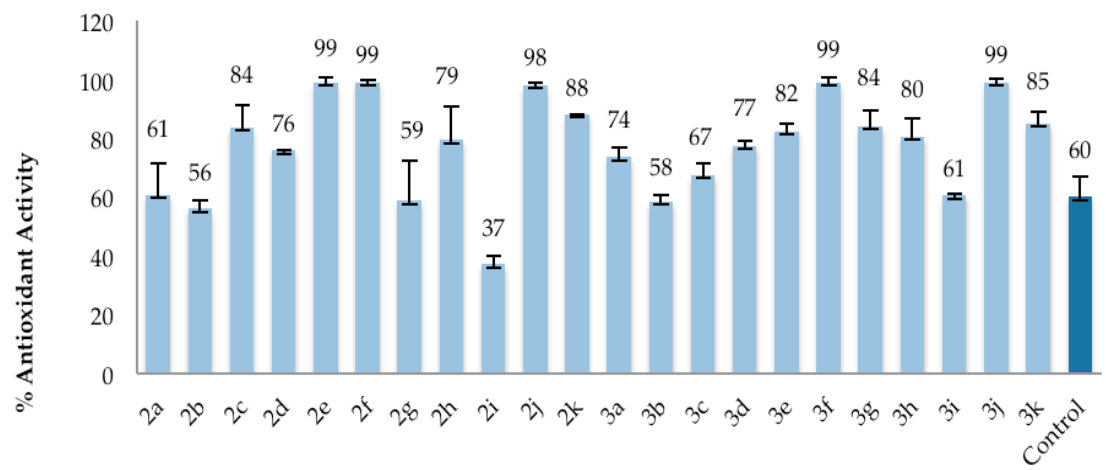
Figure 2. Percentage of antioxidant activity in β -carotene/linoleic acid bleaching assay of chalcone ( 2a – 2k ) and flavone analogs ( 3a – 3k ). α -tocopherol served as reference compound. Bars are mean ± SD, n = 2.